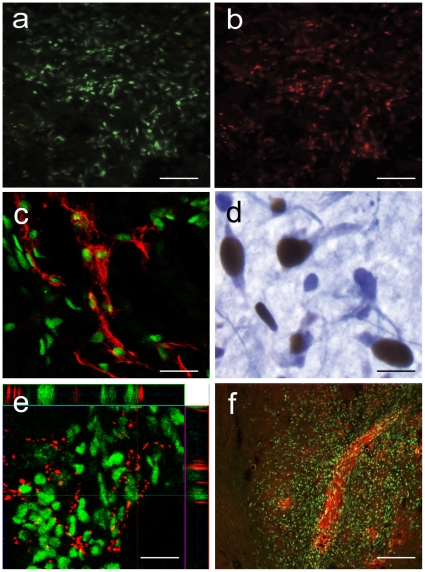
Transplanted hMNPs differentiated following transplantation.Human nuclear antigen-positive cells (a) double stained with Isl-1 (b; red), p75 (c; p75 in red, human nuclei in green), or ChAT (d; ChAT in blue, human nuclei in brown), consistent with a MN lineage of mixed maturation state. (e) Some human cells in the ventral horns were surrounded by synaptophysin positive processes, suggesting integration with host tissue (synaptophysin in red, human nuclei in green). (f) Many human cells extended Tuj1 positive processes, and in some animals, ectopic motor tracts were present in the dorsal and ventral white matter (Tuj1 in red, human nuclei in green). Bar = 100 µm for (a) and (b), 50 µm for (c) and (e), 10 µm for (d), 200 µm for (f).